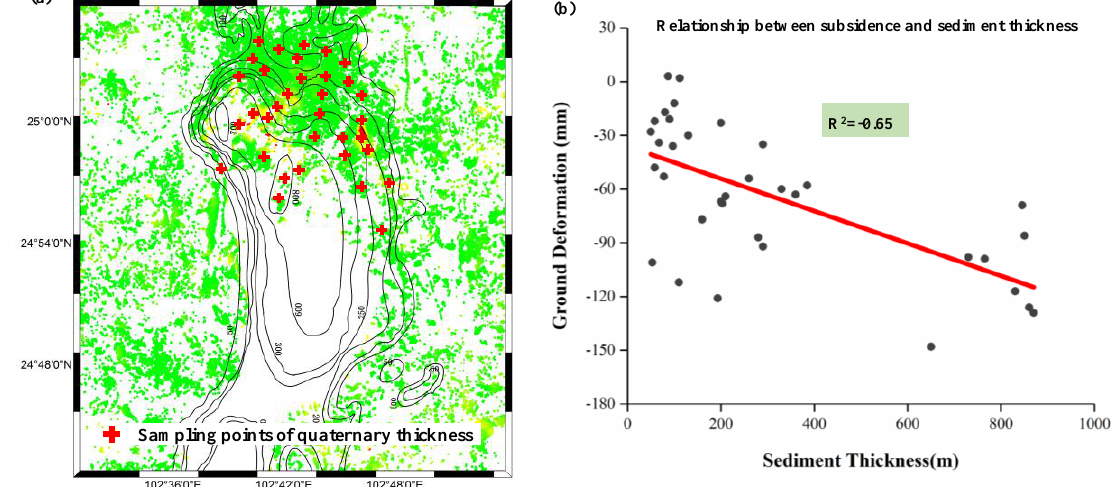
Figure 17. ( a ) Quaternary sediment thickness contours in Kunming and ( b ) relationship between ground deformation and quaternary sediment thickness.